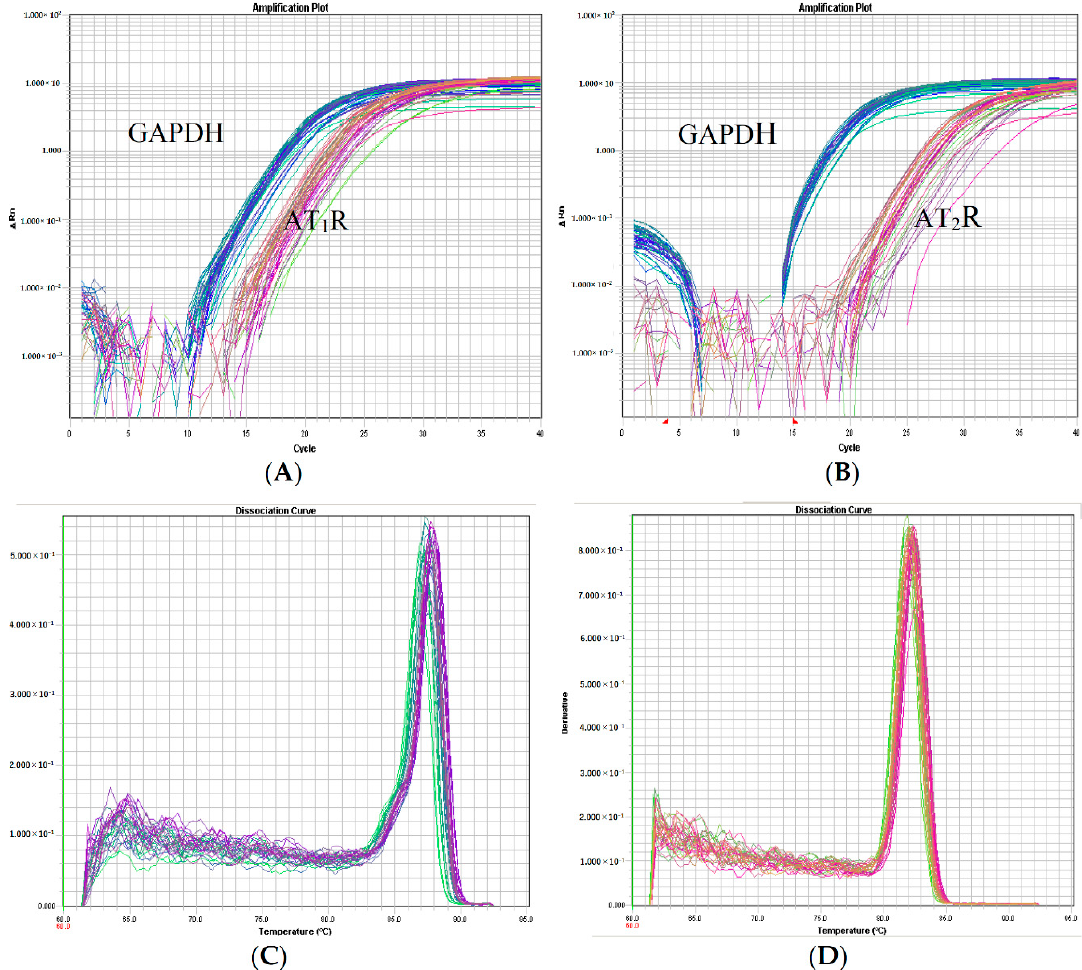
Figure 8. The amplification plots and dissociation curves of AT 1 R and AT 2 R: ( A , B ) amplification plots of AT 1 R and AT 2 R; ( C , D ) dissociation curves of AT 1 R and AT 2 R.